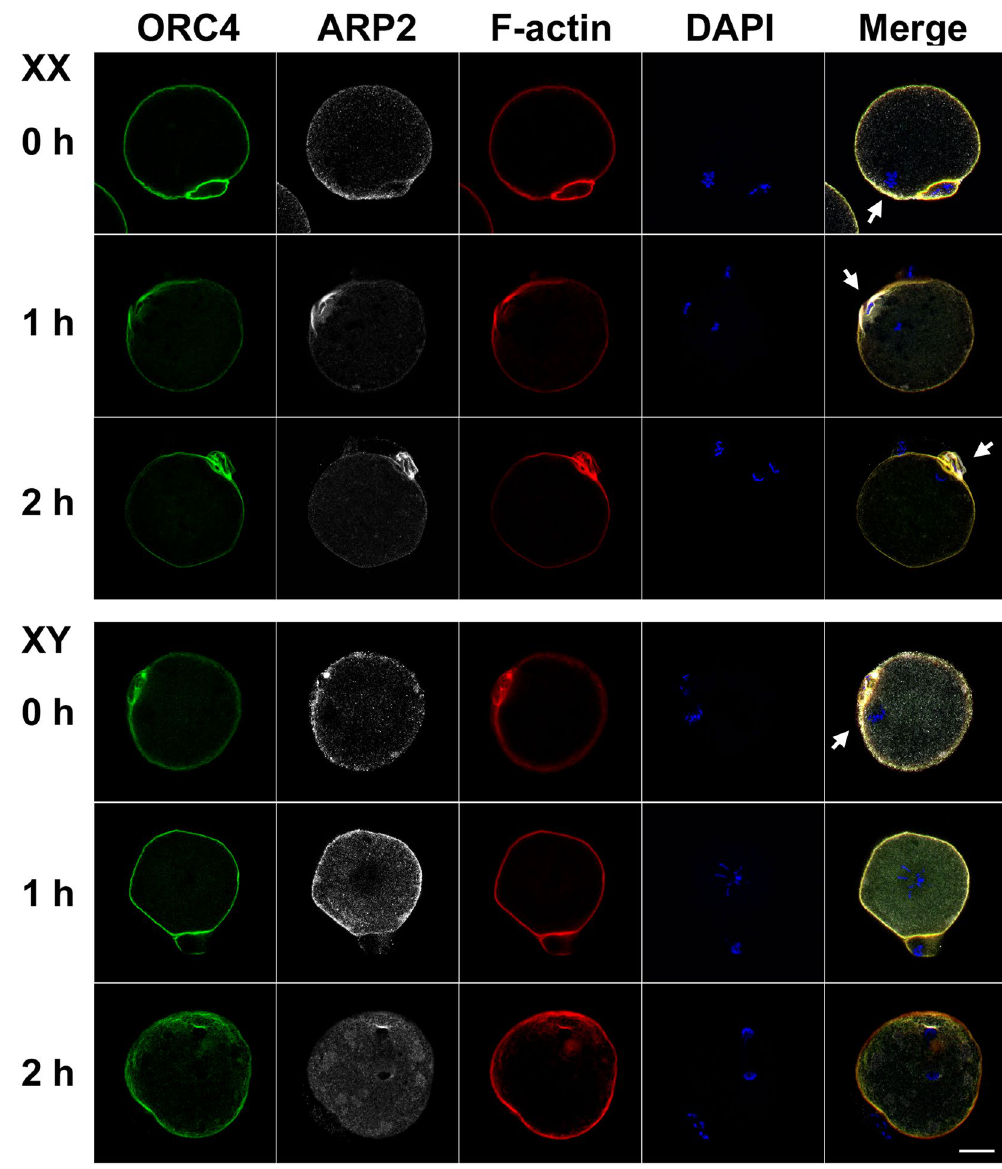
Figure 7. Loss of ORC4, ARP2 and F-actin polarization in the MII-oocytes from XY females after parthenogenic activation. ORC4, ARP2, and F-actin are localized along the oolemma and concentrated over the MII-spindle (arrows) in the ovulated-oocytes from both XX and XY females. ORC4 and F-actin are also concentrated but ARP2 is faint around the first polar body. After parthenogenic activation in the oocytes from XX females, all proteins are concentrated near the set of anaphase chromatids closer to oolemma (arrow) at 1 h and around the second polar body (arrow) at 2 h. In the oocyte from an XY female, by contrast, all proteins are localized evenly along the oolemma and, in addition, ARP2 has appeared in the ooplasm while the sister- chromatids are centered at 1 h after activation. In the oocyte at 2 h after activation, APR2 has disappeared from the oolemma entirely and distributed in the ooplasm while all ORC4, ARP2, and F-actin are concentrated around the set of anaphase chromatids near the oolemma. Bar: 20 µ m. The experiments were repeated three times. Total 3, 10, and 10 oocytes of each genotype were examined at 0, 1, and 2 h,